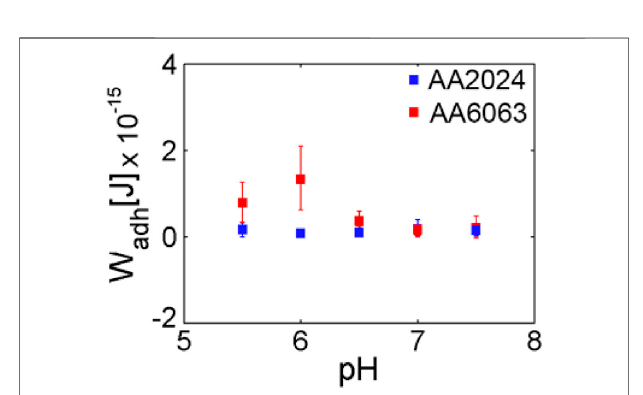
FIGURE 8 | Average work of adhesion for AA2024 and AA6063 aluminum alloy surfaces as a pH function. A clear maximum on the adhesion work is observed for pH near